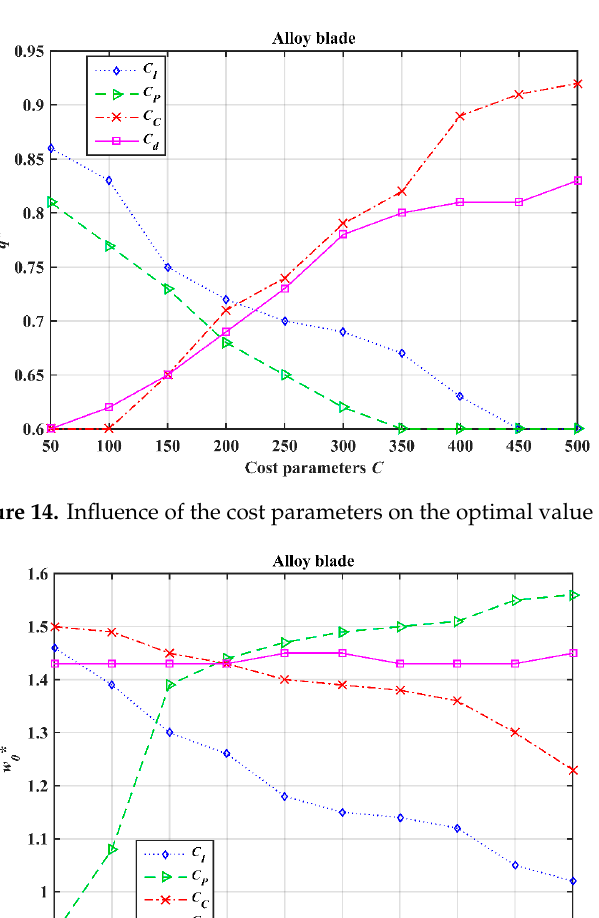
Figure 13. Total expected number of inspections versus the PM threshold 𝑤 (cid:2868) at 𝑞 = 0.95 .